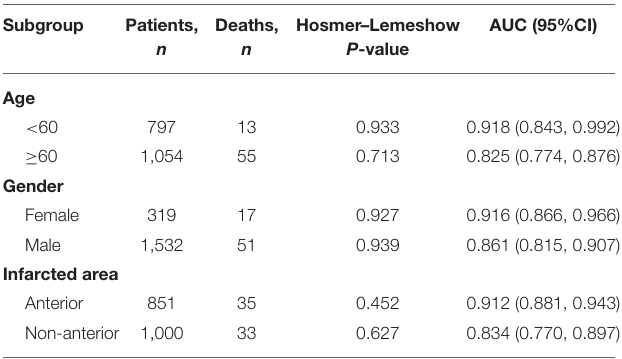
FIGURE 2 | ROC curves of shock index, Cockcroft-Gault, shock index-C, and the prediction score developed by including the shock index and Cockcroft-Gault in the logistic model for in-hospital mortality in the derivation database.